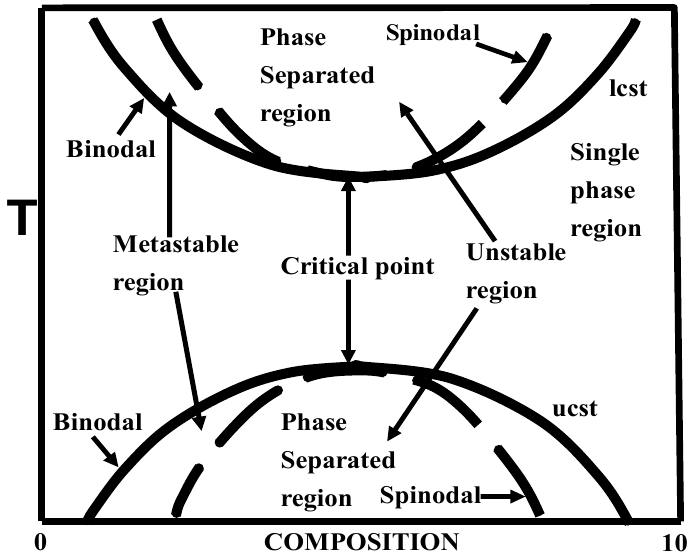
Figure 1. Phase diagram for binary polymer blend (temperature versus composition) with illustration of lower critical solution temperature (LCST) and upper critical solution temperature (UCST)